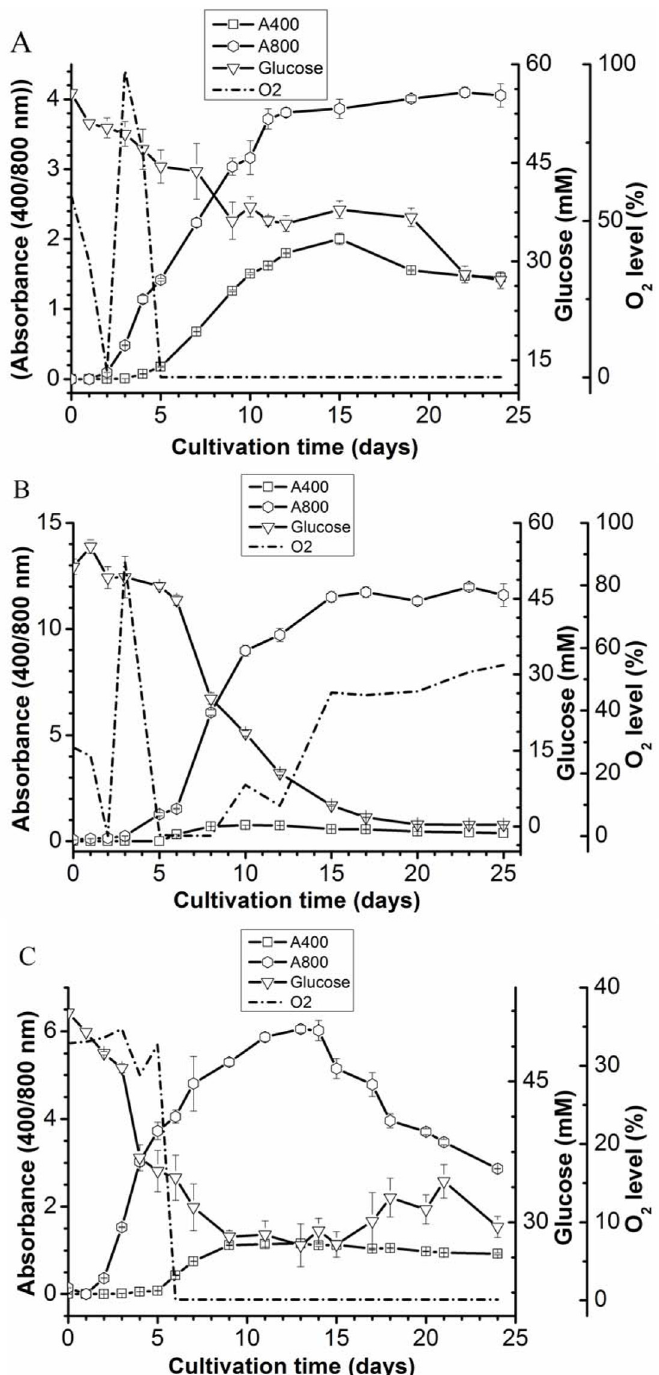
Fig 4. Effect of oxygen limitation on the porphyrin-like compound production and growth of G . sulphuraria 074G. Absorbance 400 nm: Porphyrin-like compound; Absorbance 800 nm: total biomass. (A) Following inoculation, the cultures were incubated mixotrophically without additional air supply. (B) Growth of G . sulphuraria 074G under an initial air supply rate of 5 L/min and termination of the air supply at the mid- exponential phase (day 5); (C) Growth when the active aeration of the culture was switched on at the mid- exponential phase (day 5).